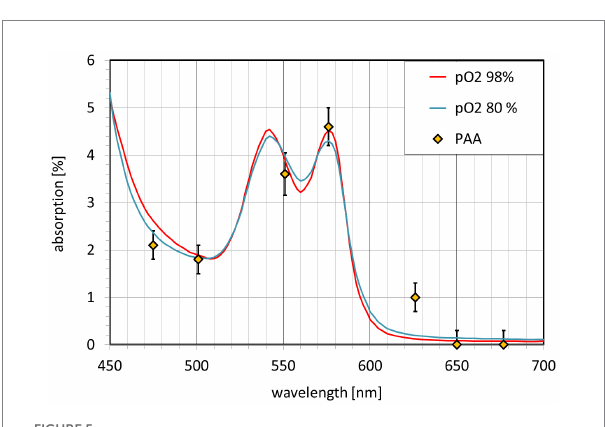
FIGURE 5 Pulsatile absorption amplitude PAA( λ ) (diamonds) and light absorption A( λ ) of an equivalent blood layer. The blood absorption A( λ ) is shown for O 2 saturation greater 98% (red) and 80% (blue).